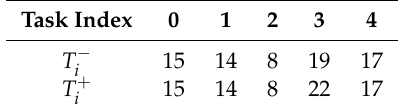
Table 3. The feasible range of each task period after applying all static/dynamic